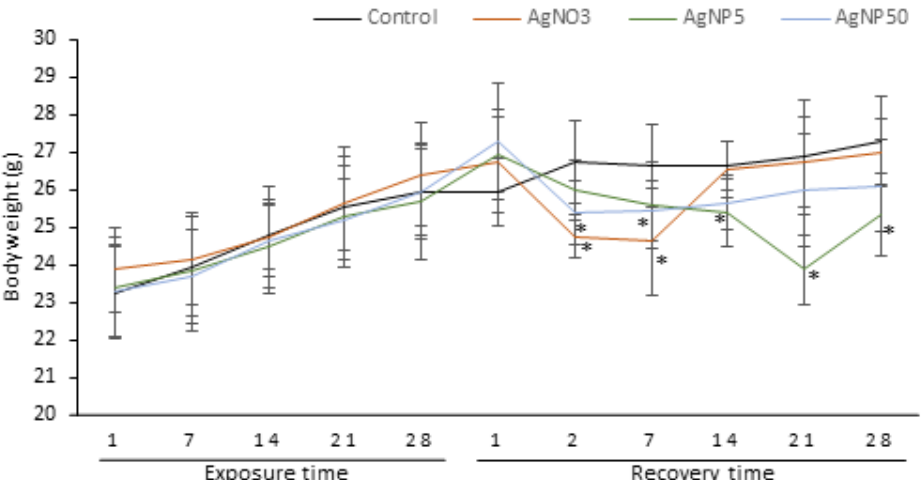
Figure 2. Mice body weight changes during a 28-day exposure via intratracheal instillation of saline (control), AgNO 3 , AgNP5 and AgNP50 and a 28-day recovery time. * means significant differences vs. last day of exposure (one-way ANOVA; Holm–Sidak p ≤ 0.05) ( n = 4).